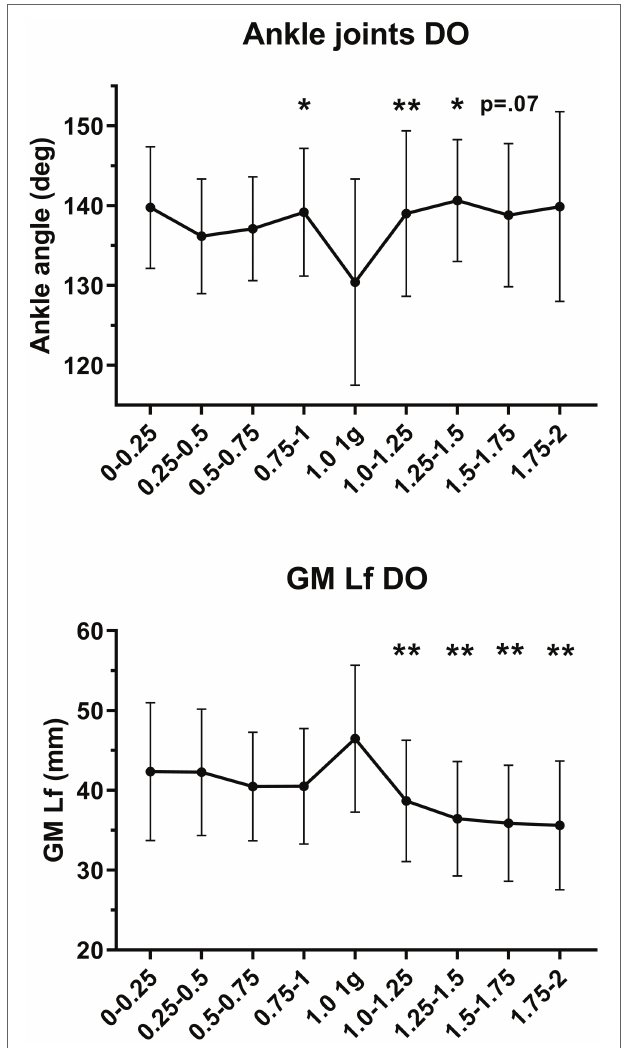
FIGURE 10 | Ankle joint angles and gastrocnemius medialis (GM) fascicle length (Lf) at drop-off (DO) in all the hypo-gravity levels (0–0.25 g, 0.25–0.5 g, 0.5–0.75 g, and 0.75–1 g), hyper-gravity levels (1–1.25 g, 1.25–1.5 g, 1.5– 1.75 g, and 1.75–2 g) and in 1 g. Results shown as mean ± SD of three jumps per gravity level per subject. * p < 0.05 vs. 1 g; ** p < 0.01 vs. 1 g.